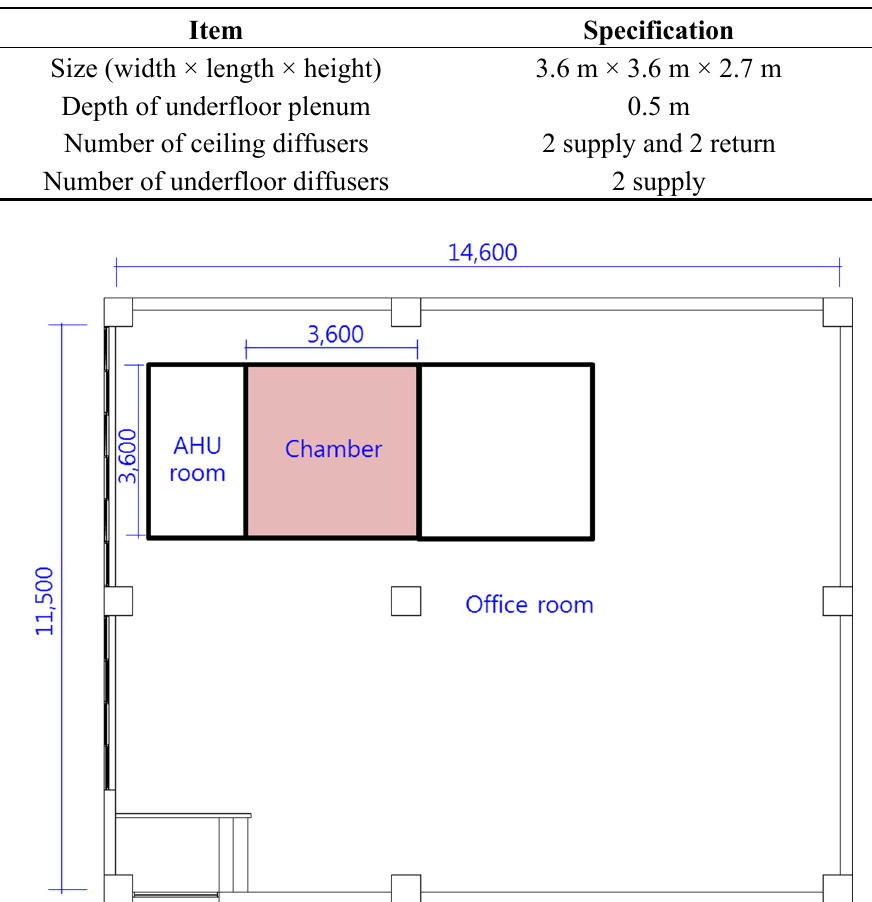
Table 1. Specifications of the chamber.